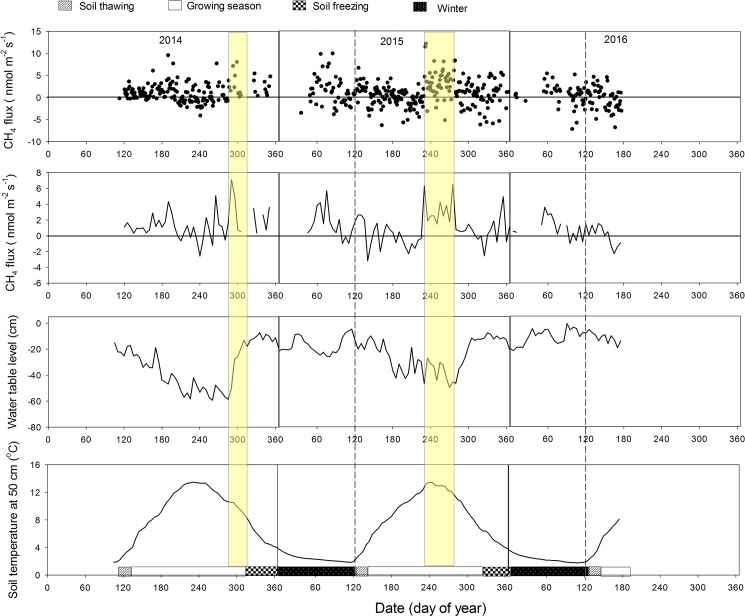
The daily average CH4 flux (a), five-day running average CH4 flux (b), five-day running average water table level (c) and five-day running average soil temperature at 50 cm (d) of different periods during the two study years.